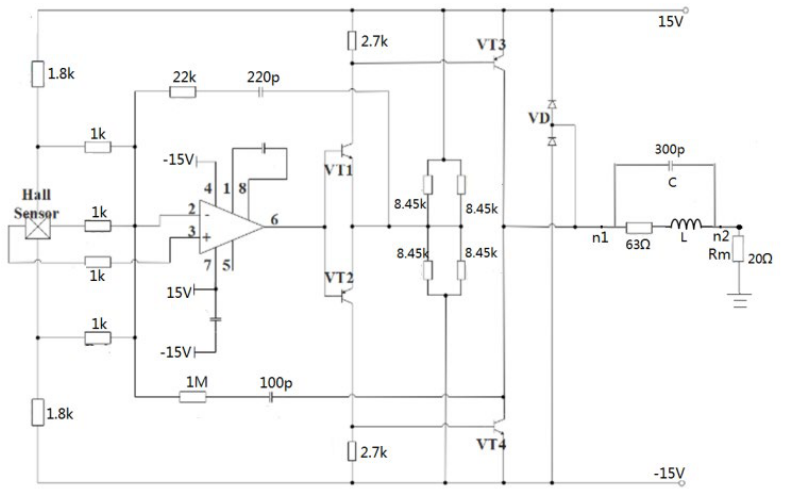
Figure 6. Circuit schematic for sensor.